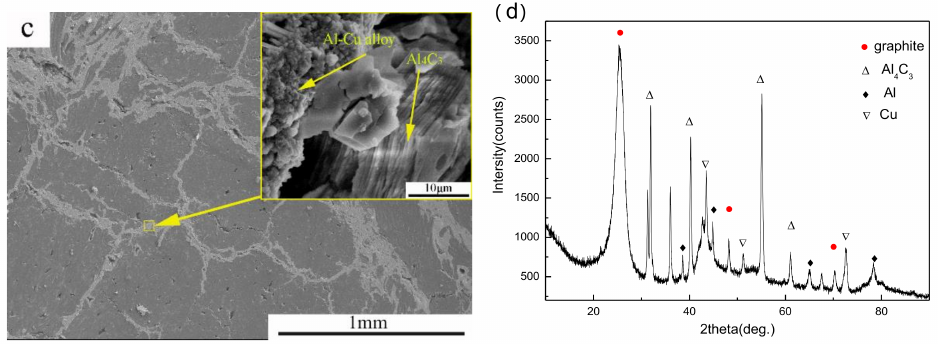
Figure 2. SEM micrographs of C/C, C/C–Al–Cu and XRD patterns: ( a ) Initial state of C/C; ( b ) metal infiltration of C/C; ( c ) formed metal network of C/C; and ( d ) XRD pattern of C/C–Al–Cu.